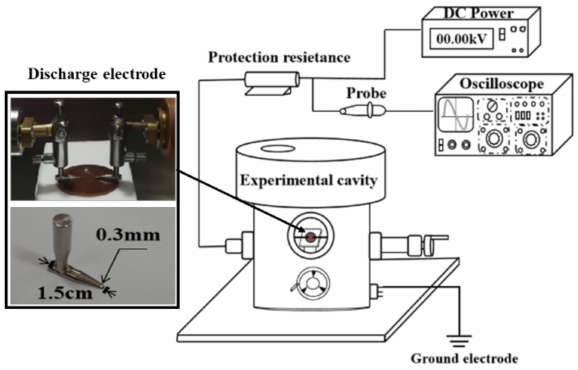
Figure 1. DC flashover experimental platform in the atmospheric environment. During the flashover test, the samples are placed in a cylindrical sealed experimental cavity. The outer diameter of the cavity is 300 mm, the height is 350 mm, and the thickness is 8 mm. The inside of the vessel is an air environment. A discharge electrode is installed inside the vessel, and a high-voltage DC power supply is connected externally through is installed inside the cavity to realize the smooth movement of the sample table.